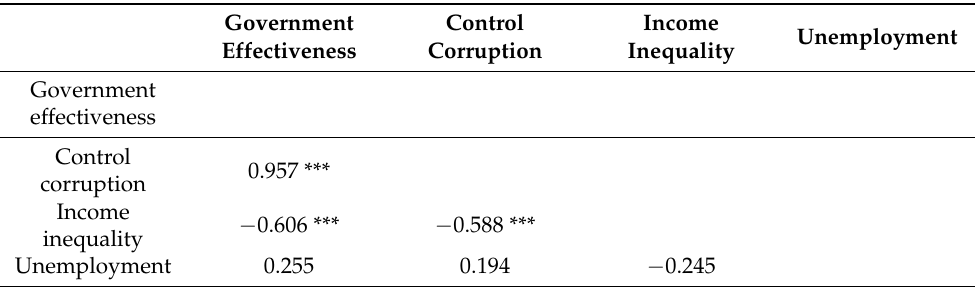
Table 2. Correlation coefficient matrix of independent variables of cross-national analysis ( n = 39). *** p <